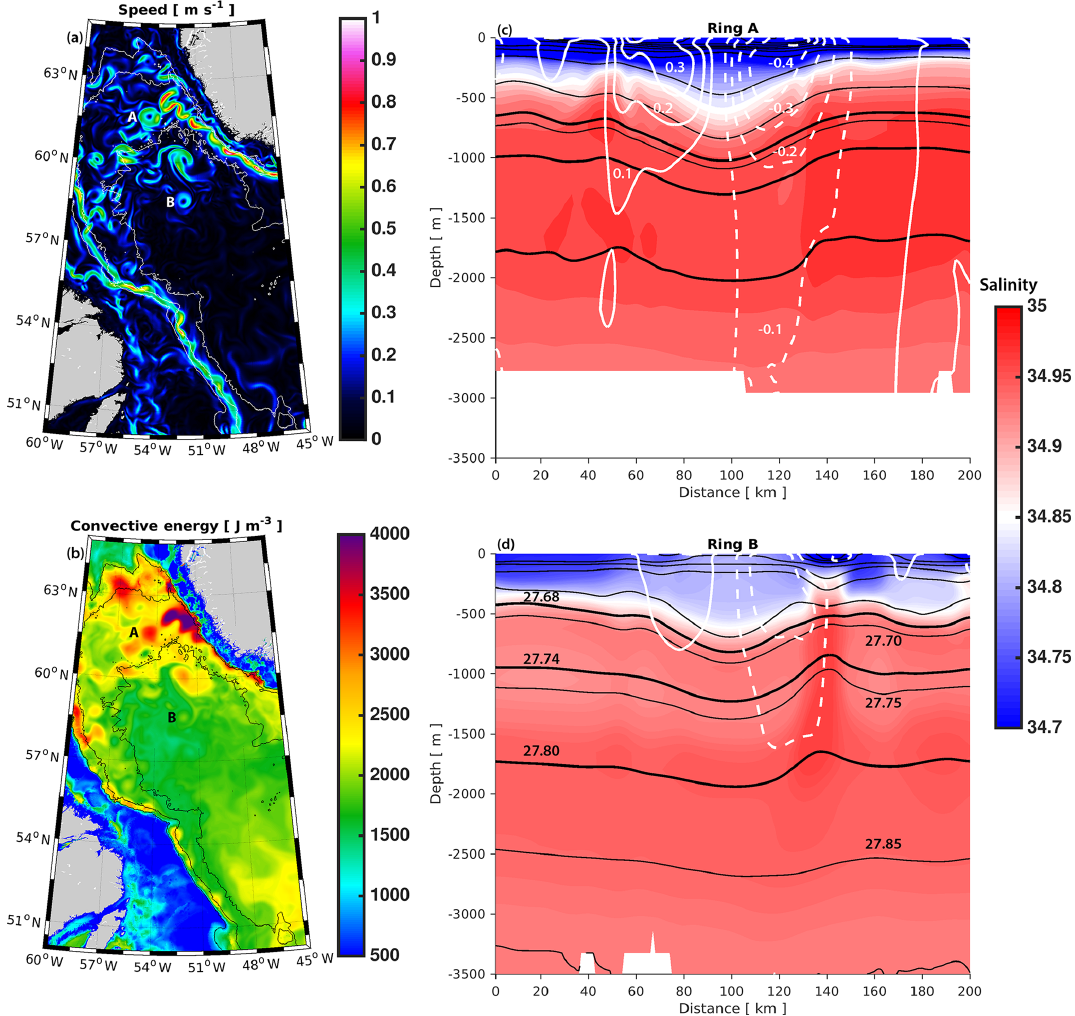
Figure 7. LAB60 snapshot (26 July 2007) of the surface speed (a) and convective energy (b) within the Labrador Sea. Two Irminger rings are identified by their age using letters: Ring A is a young Irminger ring, whereas Ring B is comparatively older. An east–west cross section through each of these Irminger rings is shown in panels (c) and (d) , respectively, where colors indicate salinity, black contours indicate potential density using a contour interval of 0.05kgm − 3 , and white contours indicate meridional velocity where the southern flow is dashed and the northern flow is solid, using a contour interval of 0.1ms − 1 . Thick black contours indicate the potential density classification of upper Labrador Sea Water ( σ θ = 27.68 to 27.74kgm − 3 ) and classical Labrador Sea Water ( σ θ = 27.74 to 27.80kgm − 3